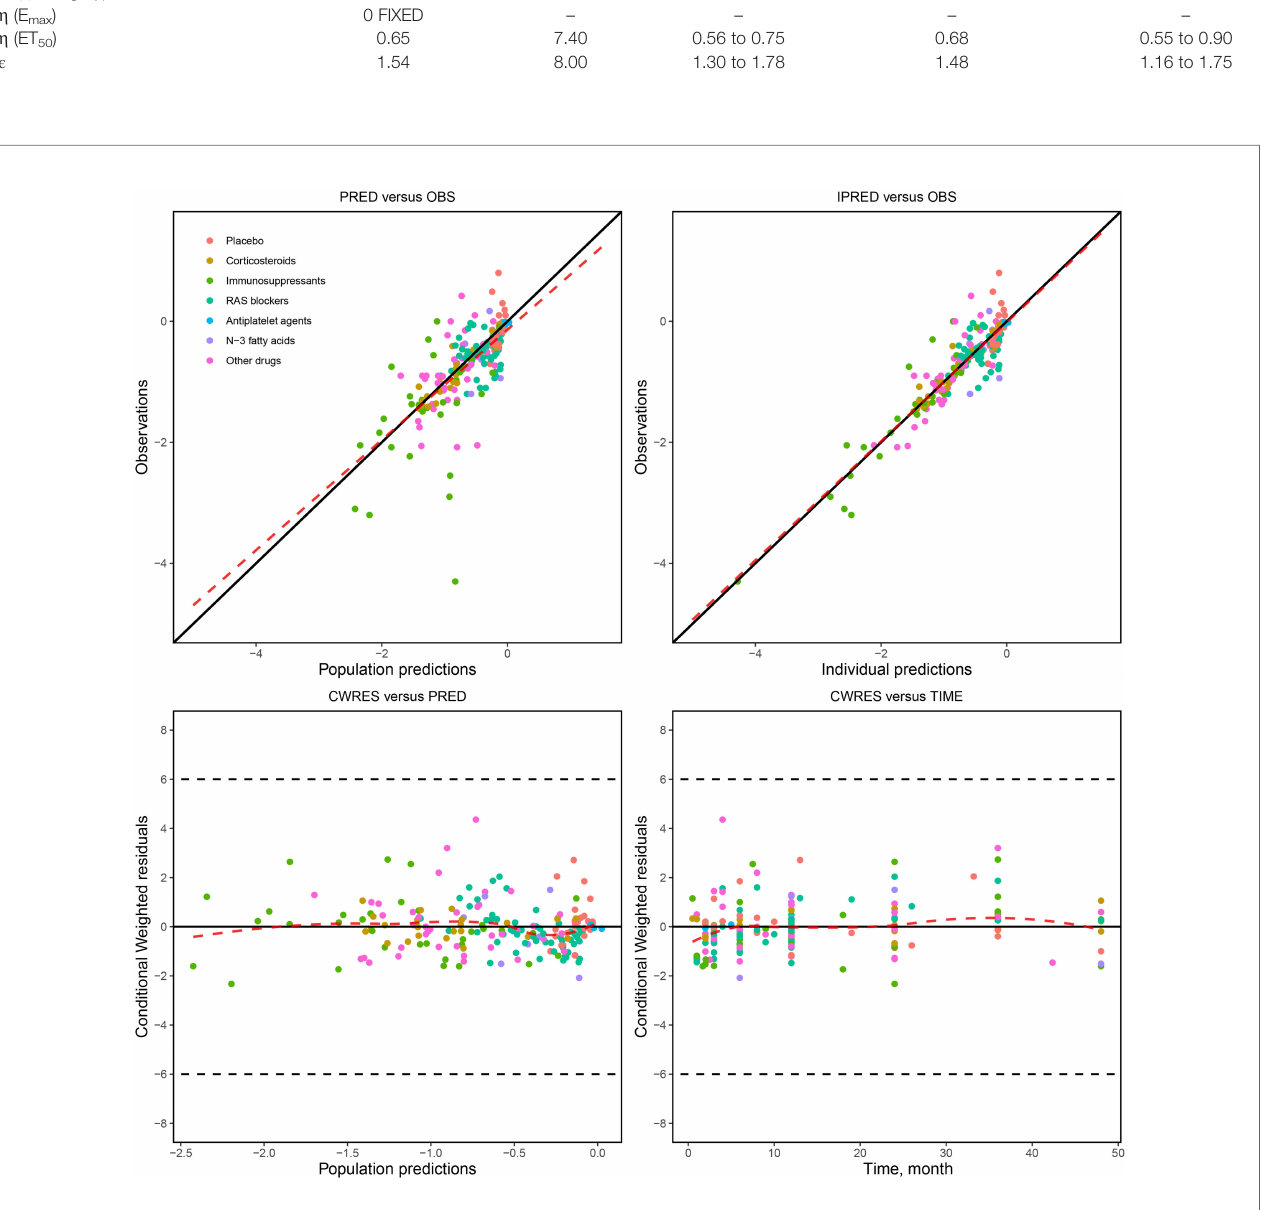
FIGURE 2 | Model diagnostic goodness-of- fi t plots.